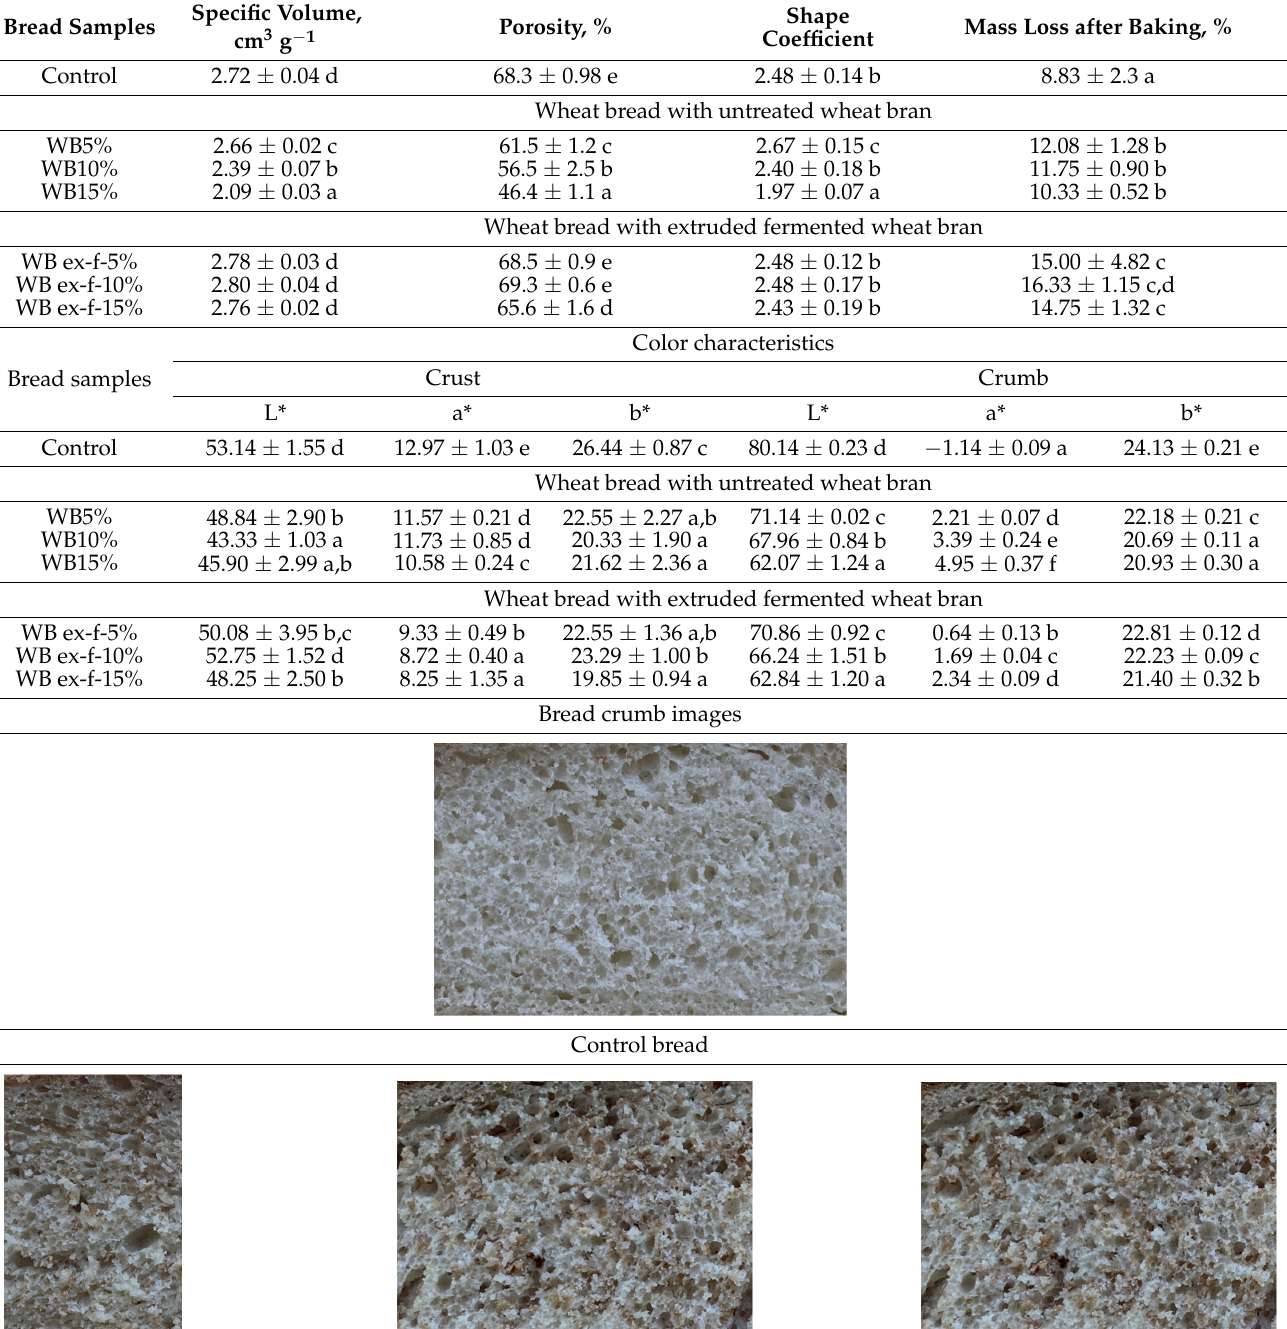
Table 2. Bread specific volume, porosity, shape coefficient, mass loss after baking, color characteristics of the bread crust and crumb, and bread crumb images.